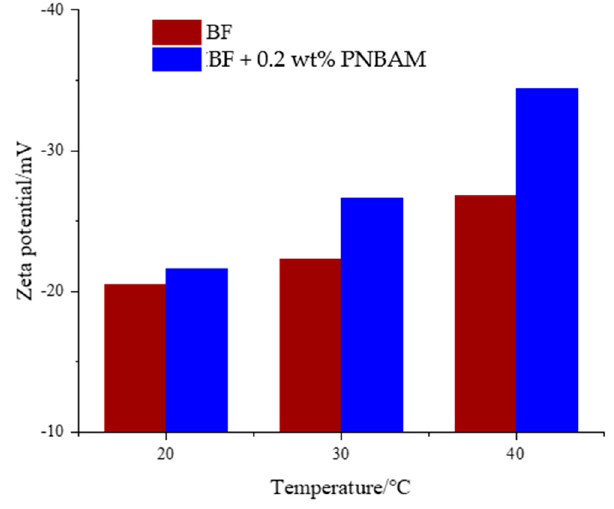
Figure 11. Value of the zeta potential for samples at different temperatures.